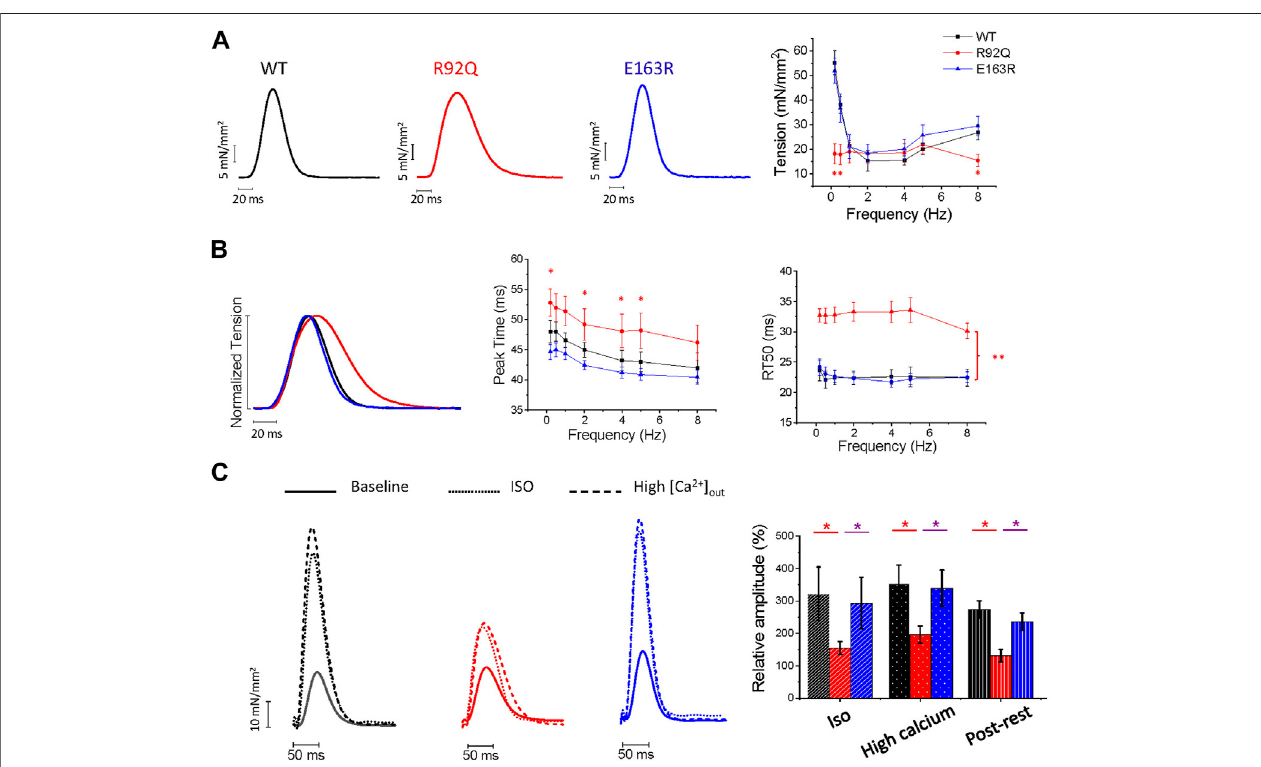
FIGURE 4 | ComparisonofisometrictwitchamplitudeandkineticsofintactatrialtrabeculaefromWT,R92QandE163Rmice. (A) Left:representativetensiontracesof twitches from intact atrial trabeculae of WT, R92Q and E163R mice under control experimental conditions (30 ° C, 2 mM external [Ca 2+ ], stimulation frequency 1 Hz). Right: relationshipbetweenstimulationfrequencyandpeakisometrictwitchtensioninthethreegroupsofintactatrialtrabeculae. (B) Left:normalizedsuperimposedtwitchesat1 Hz stimulationfrequency tohighlight kineticsdifferences.Center: average time topeakatdifferent stimulation frequencies inatrial trabeculae fromthe three groups. Right: average time from peak to 50% relaxation (RT 50 ) in atrial trabeculae from the three groups. (C) Inotropic interventions in atrial trabeculae. Left: superimposed traces under control conditions and following addition of isoproterenol 1 µM (ISO) or 6 mM external [Ca 2+ ] in trabeculae from WT, R92Q, and E163R mice. Right: variation of the peak twitchforcefromourcontrolconditionsfollowingISO,6 mMexternal[Ca 2+ ]andpostrestpotentiation.*= p < 0.05**= p < 0.01;One-wayANOVAwithTukeycorrection.WT (N = 9, n = 14), R92Q (N = 4, n = 10) and E163R (N = 5, n = 10) mice. N = number of animals, n = number of trabeculae.